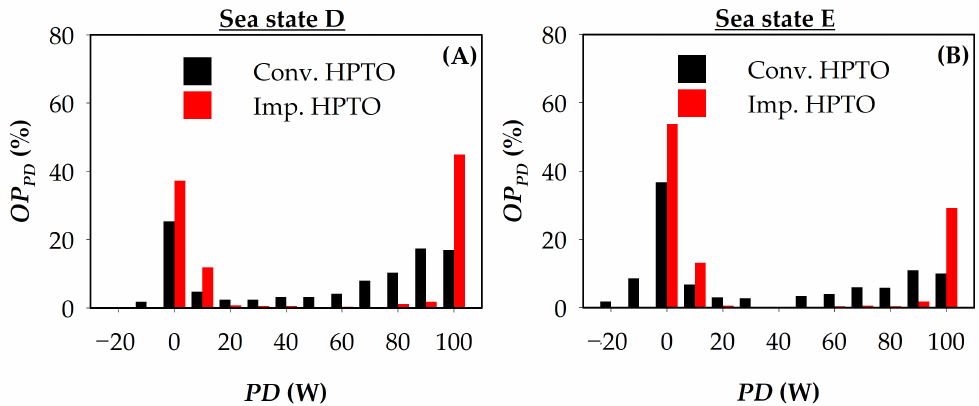
Figure 20. The PD occurrences of conventional and improved HPTO units’ outputs for the significant wave period